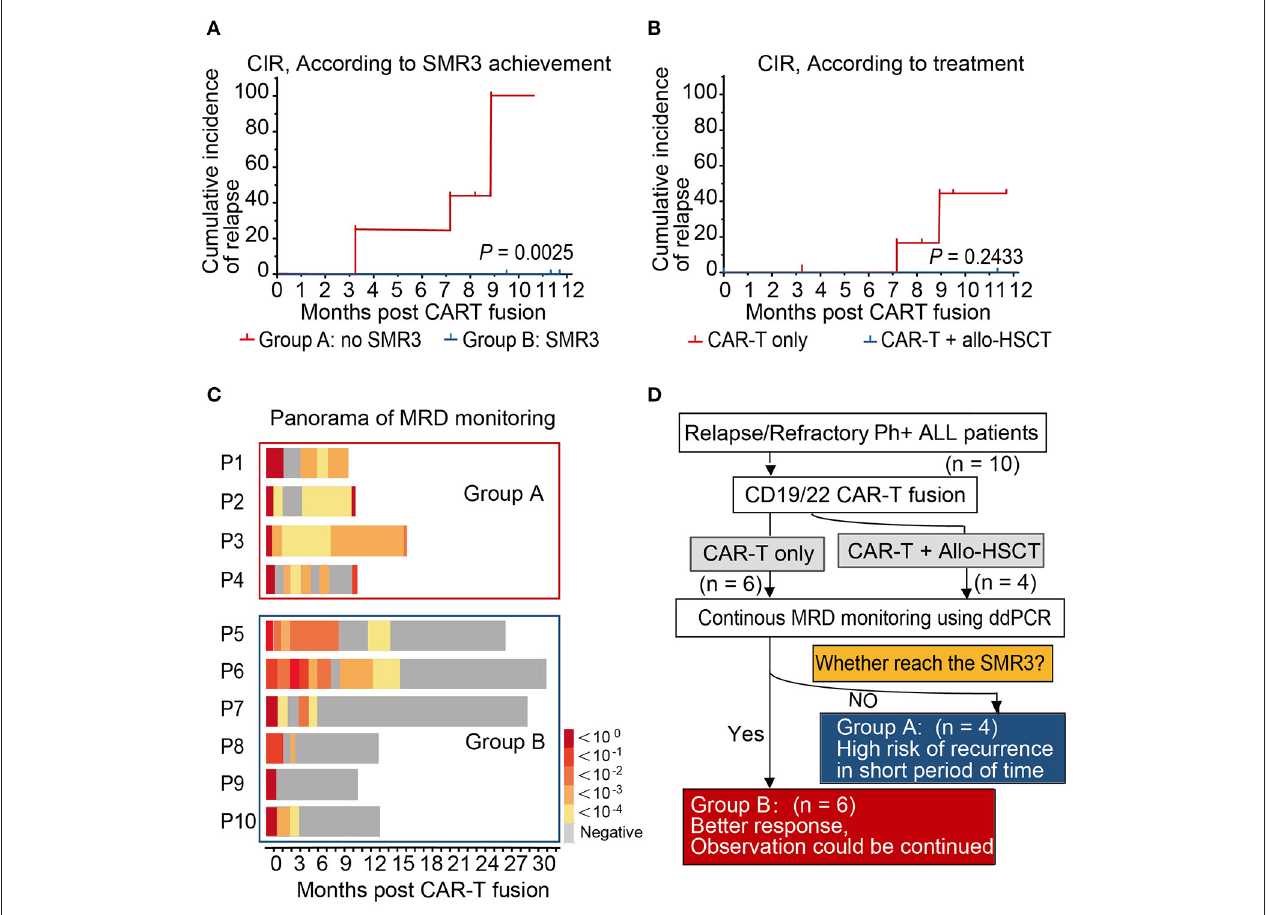
FIGURE 3 | Prognosis and panorama of MRD monitoring of patients. (A,B) The 1-year cumulative incidences of relapse of patients according to SMR3 definition and treatment. A better prognosis may be expected. (C) The full view of MRD monitoring in Group A showed a persistent negative in the follow-up, which supported the prediction efficacy of SMR3 model. (D) Patients with Ph + post-chimeric antigen receptor T-cell (CAR-T) therapy were assigned to different groups based on the sequential molecular remission for more than 3 months (SMR3) signature so as to predict the corresponding prognosis. When reaching the definition of SMR3, patients were expected to have better prognosis. However, no achievement of SMR3 may be an early warning of potential relapse and indicating the initiation of other therapies including